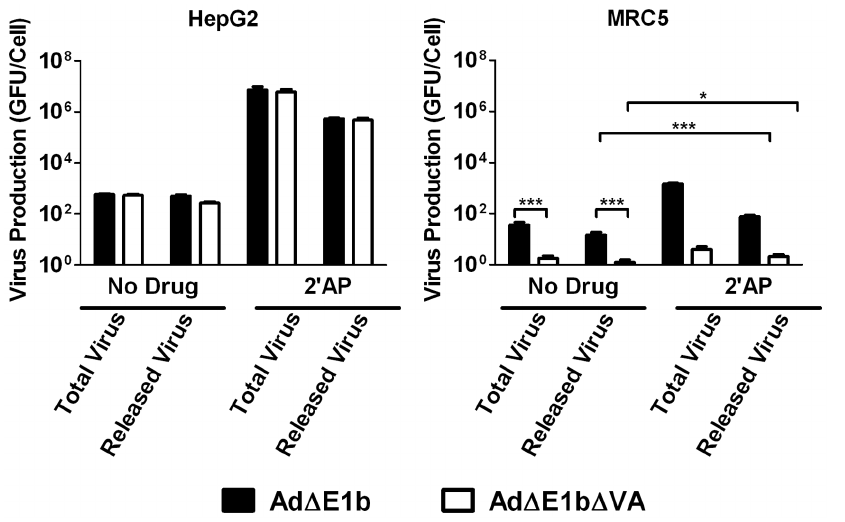
Figure 4. Treatment of HepG2 and MRC5 cells with 2.5 mM 2 9 AP inhibited Ad D E1b and Ad D E1b D VA release. Cells were infected with either Ad D E1b or Ad D E1b D VA at MOI of 1 GFU/cell for 1 hour prior to treatment with medium containing no drug or 2.5 mM 2 9 AP. Four days following infection, infected cells combined with the media (total virus) or the media alone (released virus) were harvested. Virus yields were determined by titration in Hep3B cells. Error bars correspond to + / 2 SD of quadruplicates (*p , 0.05, ***p , 0.001, one-way ANOVA).